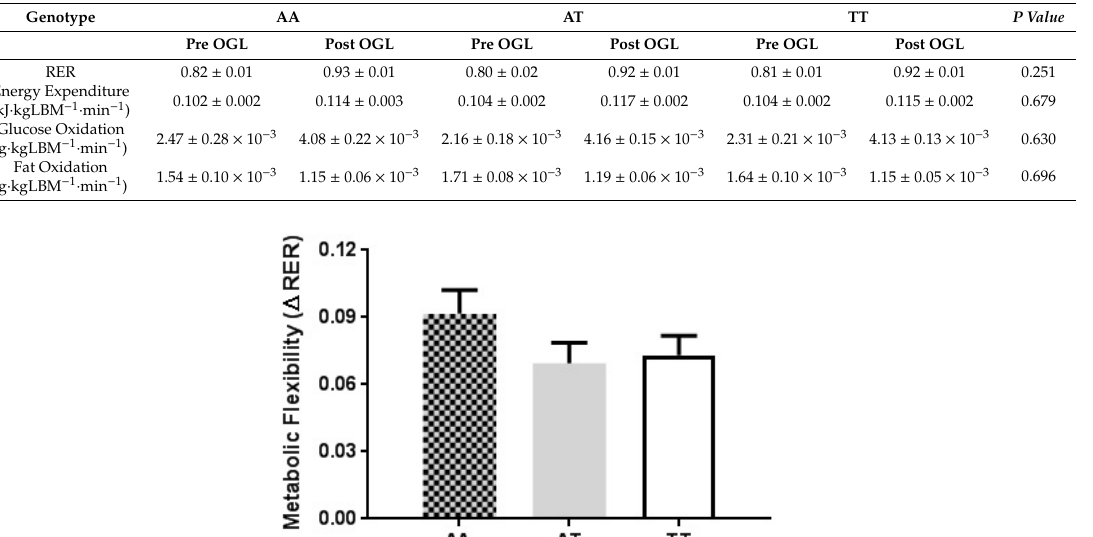
Table 4. Respiratory exchange ratio (RER), and calculated energy expenditure (EE), glucose and fat oxidation pre oral glucose load (OGL) (0 min) and 60 min post OGL, with participants separated according to their FTO rs9939609 genotype. Values are expressed as mean ± SEM.